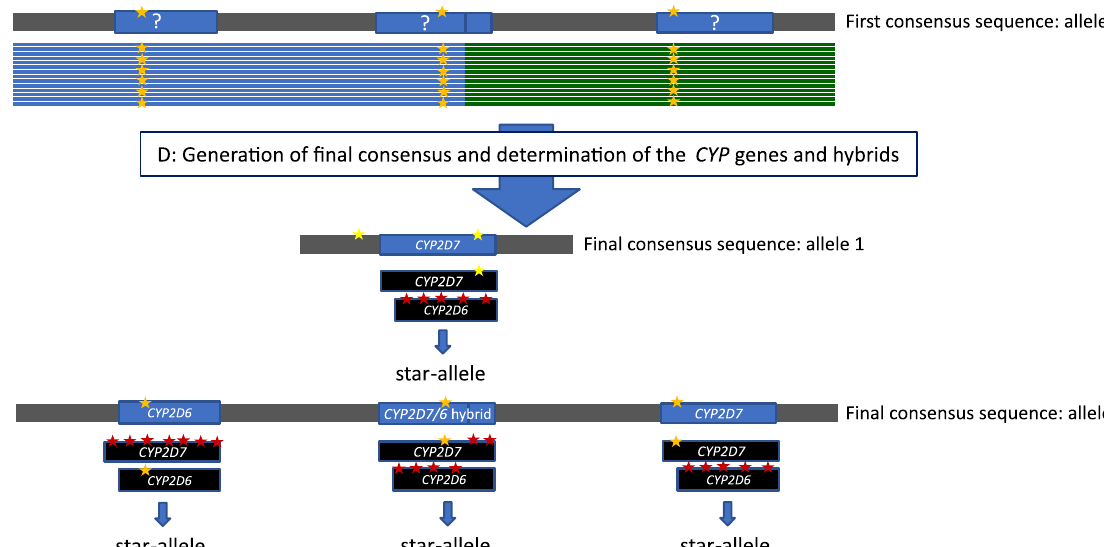
Fig 2. Workflow of the in-house developed CoLoRGen pipeline, which combines large structural and small variant calling. A: The basecalled reads are mapped against the human reference genome GRCh38 (black). Reads are split into the two alleles based on the small variants (yellow and orange stars). Clipping ends of the reads (red) are cut in-silico and mapped again to the reference genome (green). B: The reference is adapted based on the breakpoints of the clipping ends in the DNA under study (grey). Reads of alleles 1 and 2 are mapped against their respective adjusted reference sequence to create a first consensus sequence. C: The reference sequences are further adjusted by mapping all the previously mapped